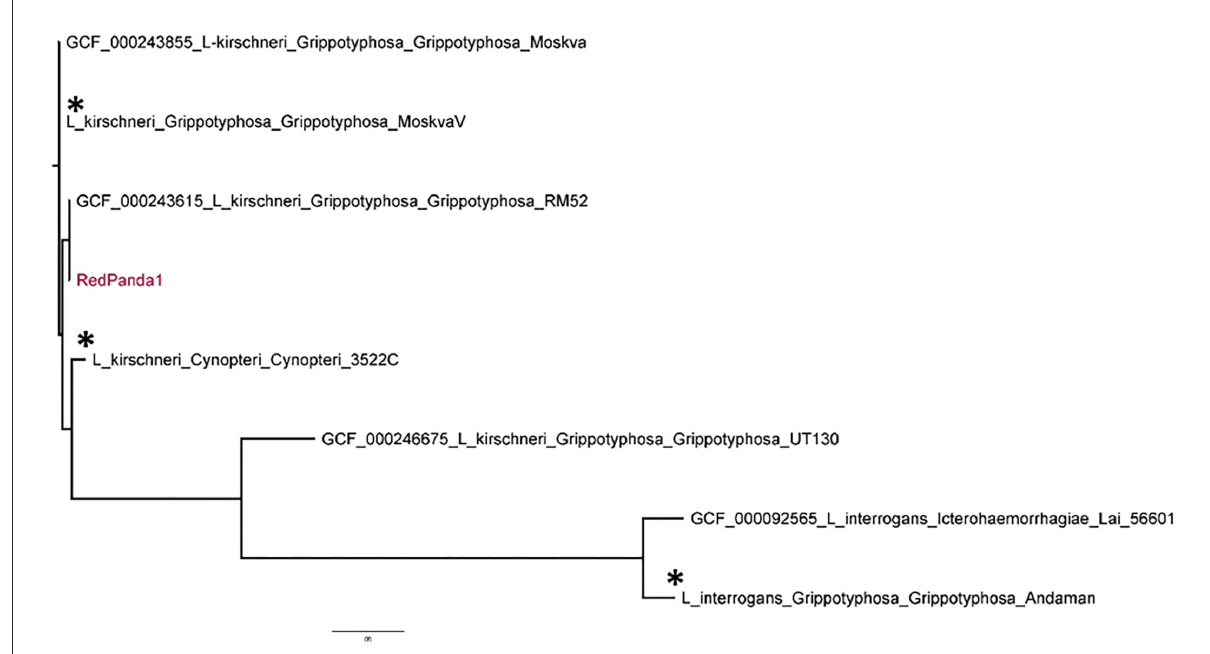
FIGURE2 Phylogenetic tree using kSNP analysis shows strain RedPanda1 grouping with Leptospira kirschneri serovar Grippotyphosa and separate from L. interrogans isolates. For those genome sequences downloaded from GenBank, accession numbers are provided followed by species_serogroup_serovar_strain. NVSL in-house genome sequences are indicated with an asterisk (*) followed by species_serogroup_serovar_strain.